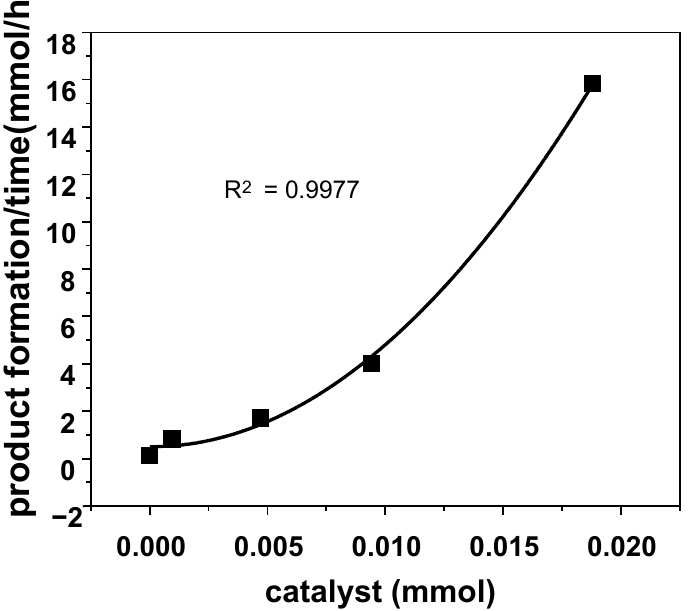
Figure 8. Kinetic analysis of the reaction order (Second order, R 2 = 0.9977). Reaction